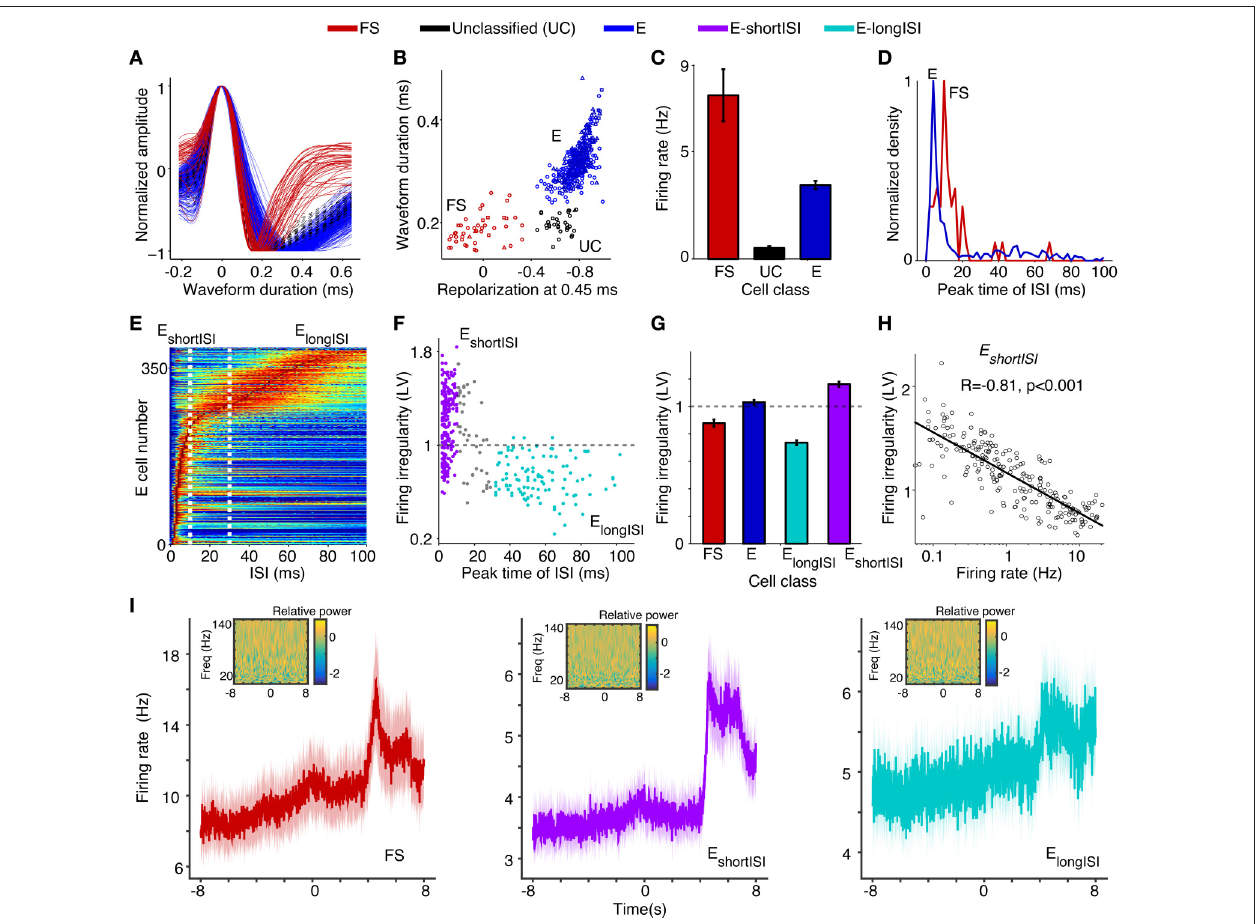
FIGURE 3 | Assignment of (extracellularly recorded) S1BF units to electrophysiological cell classes. (A) Normalized waveform amplitude as a function of time (ms) from AP peak, separately for FS (fast spiking), E (putative excitatory), and UC (unclassified) cells. (B) Normalized AP amplitude at 0.45ms (repolarization) vs. waveform peak-to-trough duration (ms), revealing three electrophysiological cell classes. Circles, squares and triangles correspond to Rat 1, 2, and 3, respectively. (C) Mean ± SEM of firing rate (Hz) for different cell classes. (D) Distribution of ISI (Inter Spike Interval) peak times across E and FS cells. (E) ISI histograms for all E neurons. The data in each row were normalized by dividing by the maximum (color scale ranges from 0 to 1). (F) Peak time of ISI vs. firing irregularity, which was measured using the LV (Local coefficient of Variation, Shinomoto et al., 2009). E shortISI cells were defined to have ISI peak times shorter than 10ms. E longISI cells were defined to have ISI peak times in excess of 30ms. Gray dots correspond to cells attaining intermediate values. (G) Mean ± SEM of firing irregularity (LV) for different cell classes. (H) Log 10 of firing rate vs. firing irregularity (LV), together with linear regression fit. Each dot corresponds to one E shortISI cell. (I) Average peri-stimulus histograms ± SEM (bin size 10ms) as a function of time from visual cue onset (in seconds), separately for FS, E shortISI and E longSI cells. Insets show the wavelet transform of the average peri-stimulus histogram with bin size 2ms, using seven cycle wavelets with Hanning taper for each frequency. Relative power (i.e., power normalized to total sum power), obtained via wavelet transform, is shown on log 10 scale.